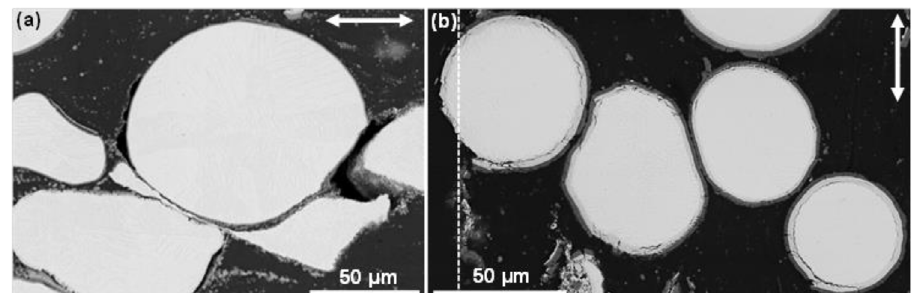
Fig. 5. SEM micrographs taken on cross-sections of (a) EMP-828, (b) EMP-819 plates (white arrows: rolling direction (cid:3) dashed line: approximate location of fuel-cladding